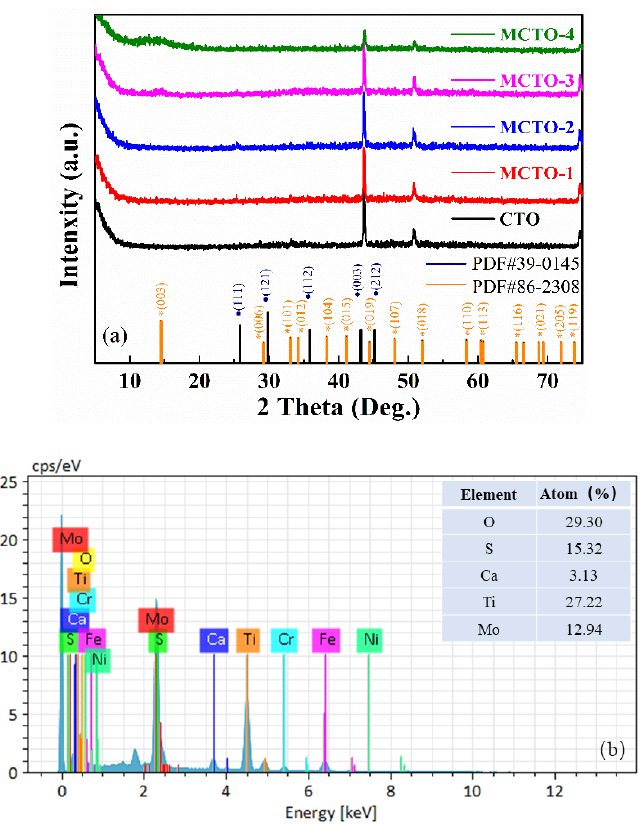
Figure 1. ( a ) X-ray diffraction patterns of samples obtained at 450 °C for 2 h; ( b ) EDS pattern of MCTO-2 sample.